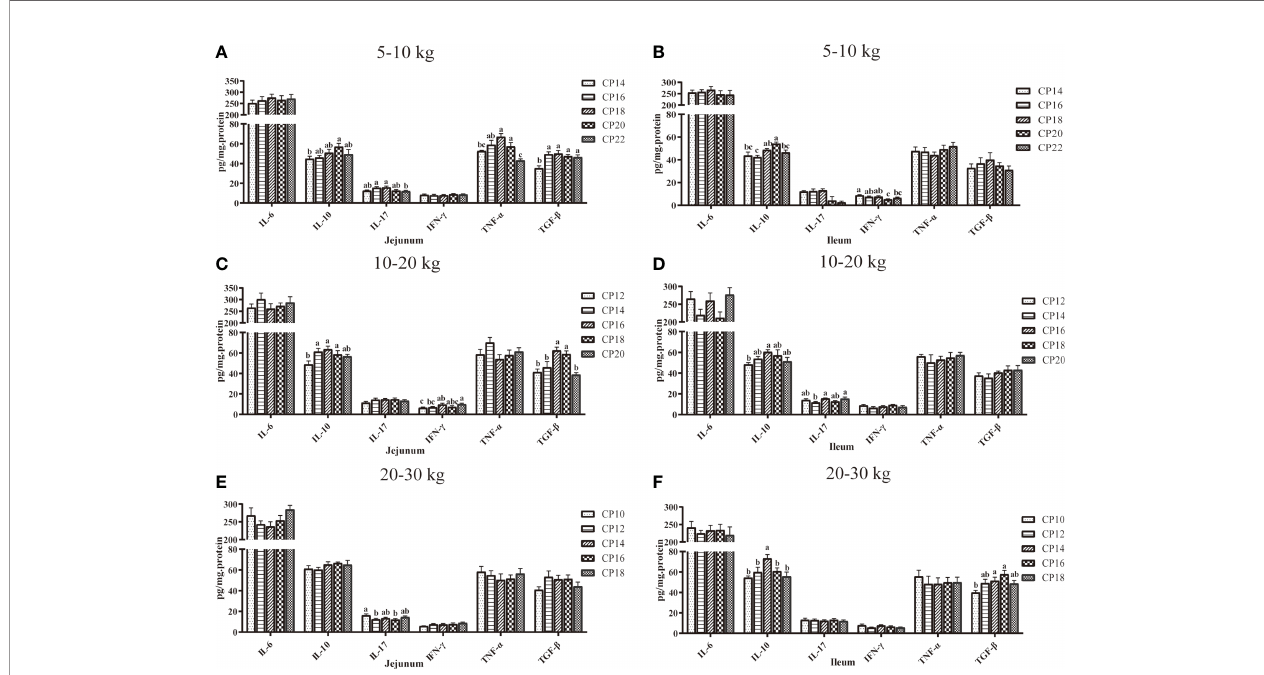
FIGURE 5 | Effects of dietary crude protein (CP) levels on cytokine concentrations in the small intestinal mucosa of Huanjiang mini-pigs during 5 − 10 kg ( A , jejunum; B , ileum), 10 − 20 kg ( C , jejunum; D , ileum), and 20 − 30 kg ( E , jejunum; F , ileum) growth stages. Data are presented as means ± SE ( n = 6 − 8 per group). Different superscript letters indicate signi fi cant differences among the fi ve groups ( P < 0.05). IL, interleukin; IFN, interferon; TNF- a , tumor necrosis factor-alpha; TGF- b , transforming growth factor-beta.